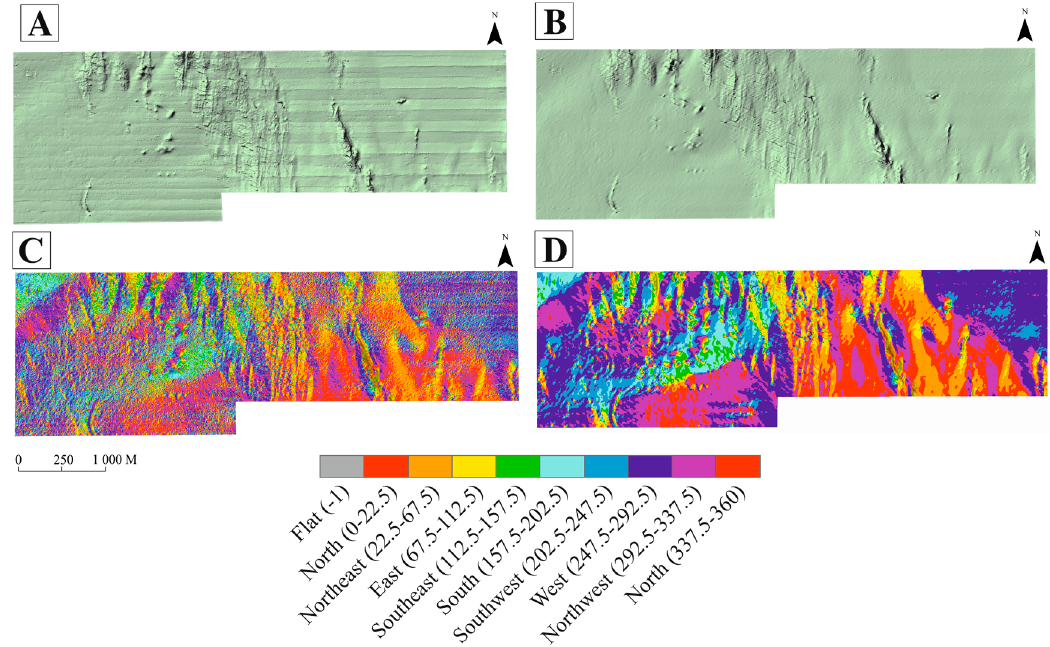
Figure 3. Orientation of the seabed calculated from the models (Moschny Island key area). ( A ) initial shaded relief prior to approximation; ( B ) shaded relied after approximating and de-striping; ( C ) initial seabed slope prior to approximation; ( D ) seabed representation after approximating and de-striping.